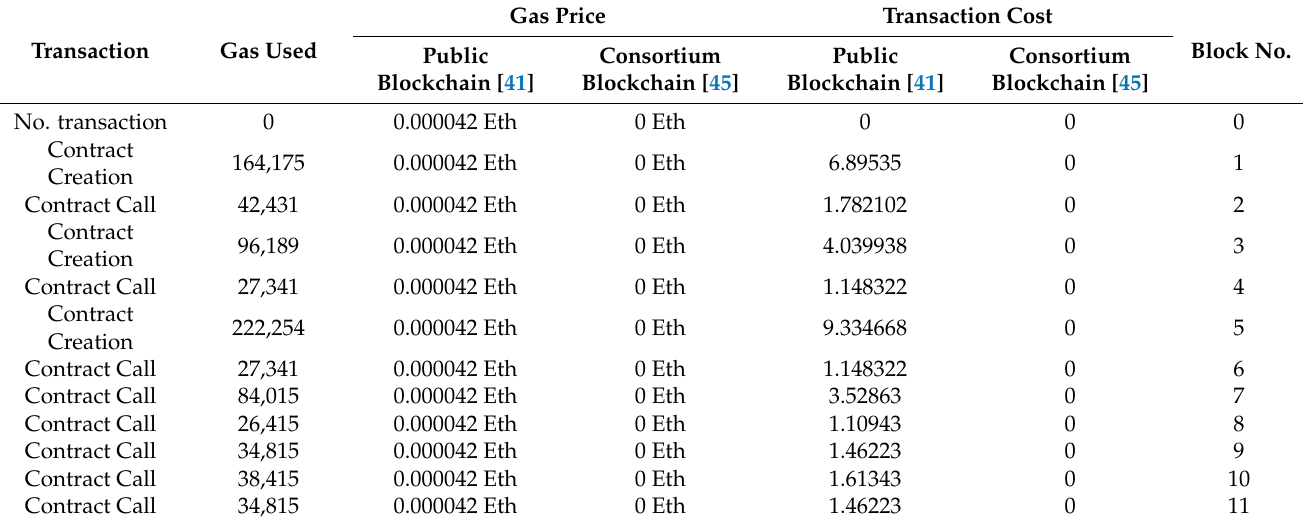
Table 4. The comparison of transaction costs between Truffle and QBN operation using 12 blocks.